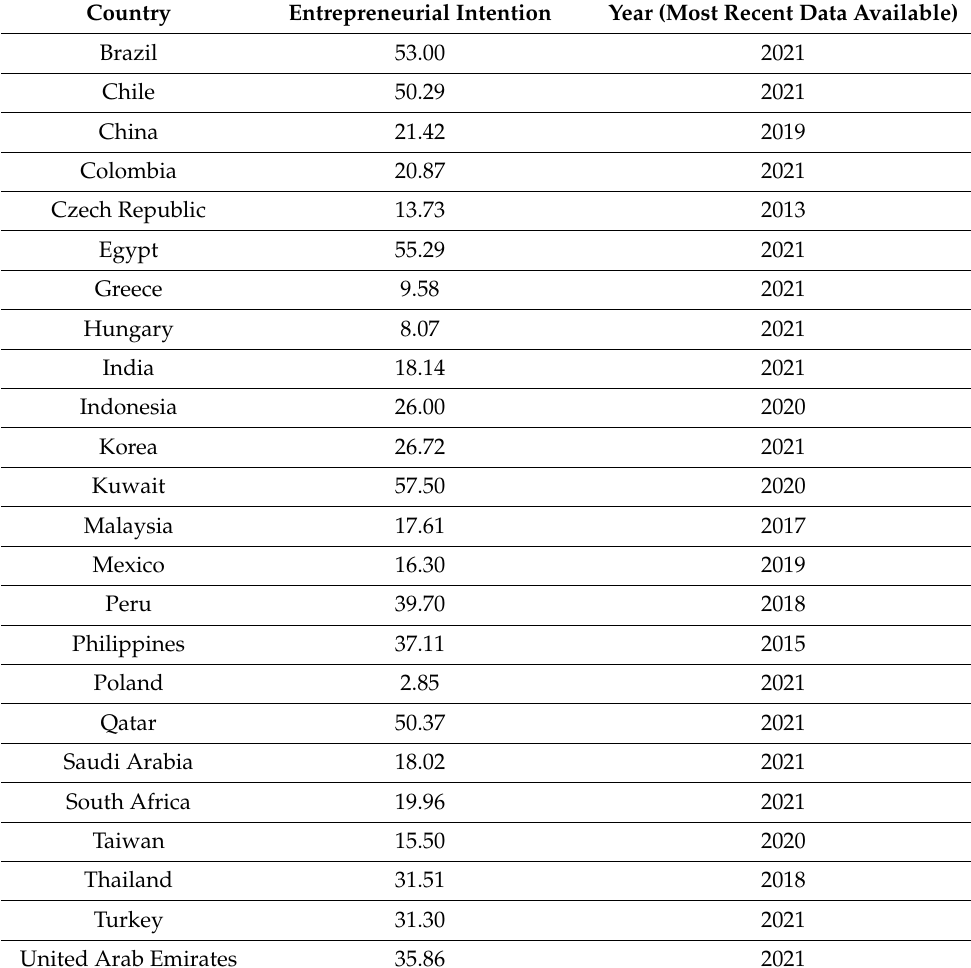
Table 1. Emerging markets entrepreneurial